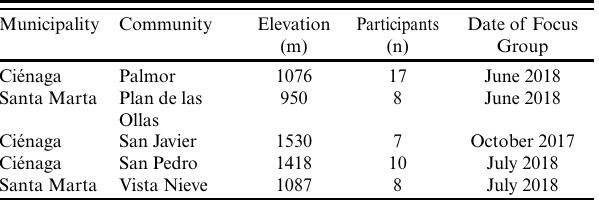
Table 1 . Information about focal group demographics and landscapes.